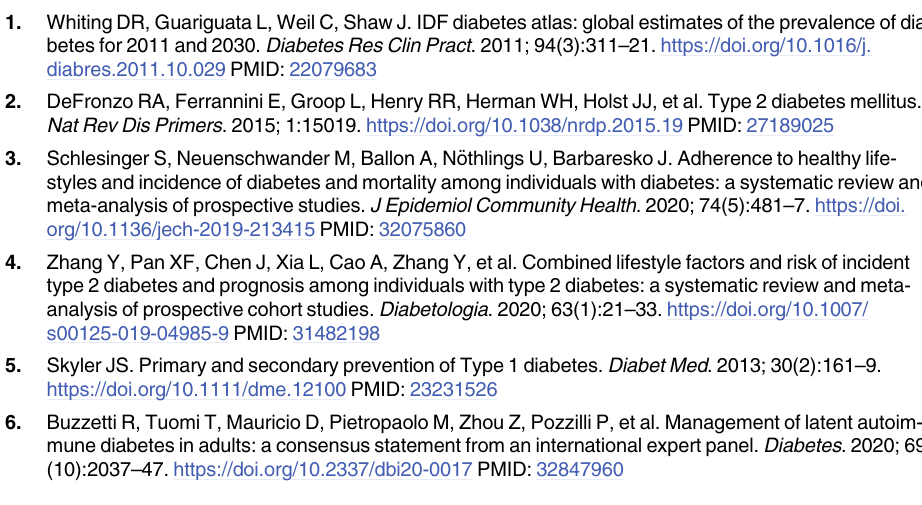
S3 Table. Comparison of algorithmic performance across internally- and externally-vali- dated